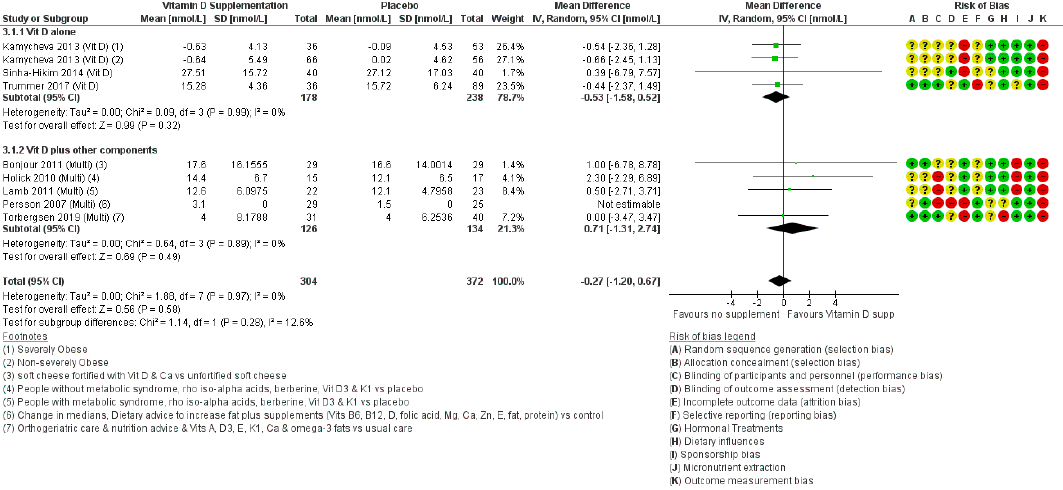
Figure 3. Forest plot assessing effects of increasing vitamin D intake and vitamin D amongst other nutrients, on IGF-1 (nmol/L). Multi, multi-nutrient; vit D, vitamin D. Please refer to Supplementary Table S5, E to find detailed information on the studies and reference details.